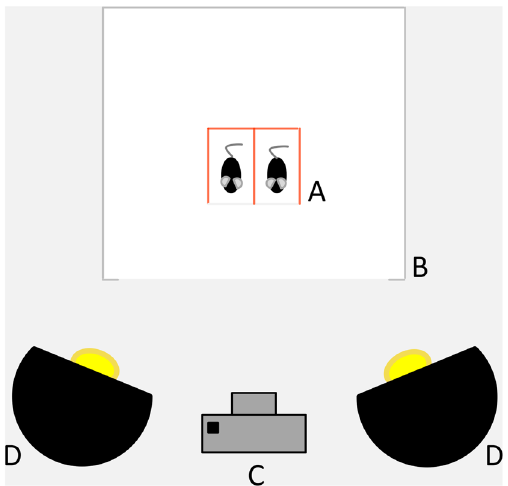
Figure 2. Schematic display of Mouse Grimace Scale assessment. Mice are placed in polycarbonate boxes ( A ) within a white light tent ( B ). They are filmed for 5 min by a digital camera ( C ) while being illuminated at an angle from the front by two light bulbs ( D